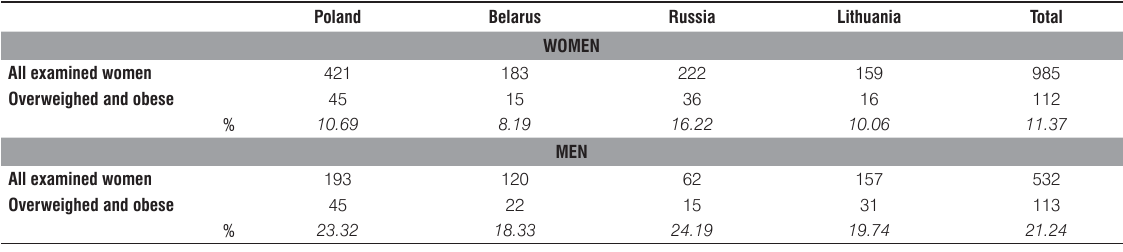
Table 1. The prevalence of overweight and obesity in female and male groups